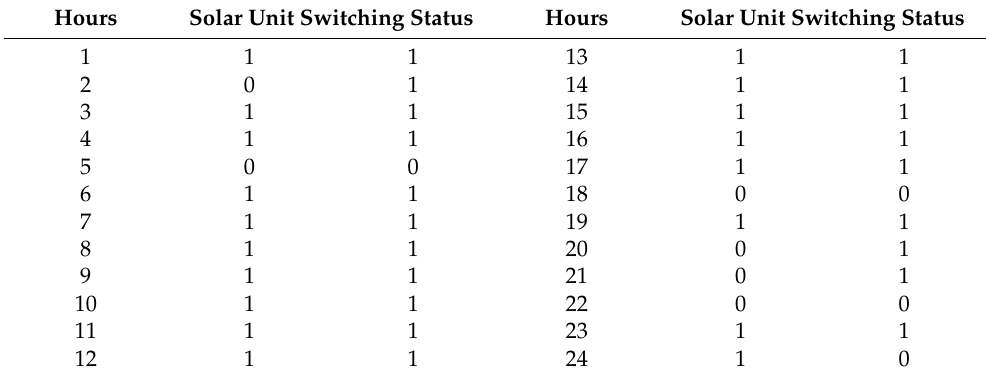
Table 25. Solar unit switching status along with the operational hours.